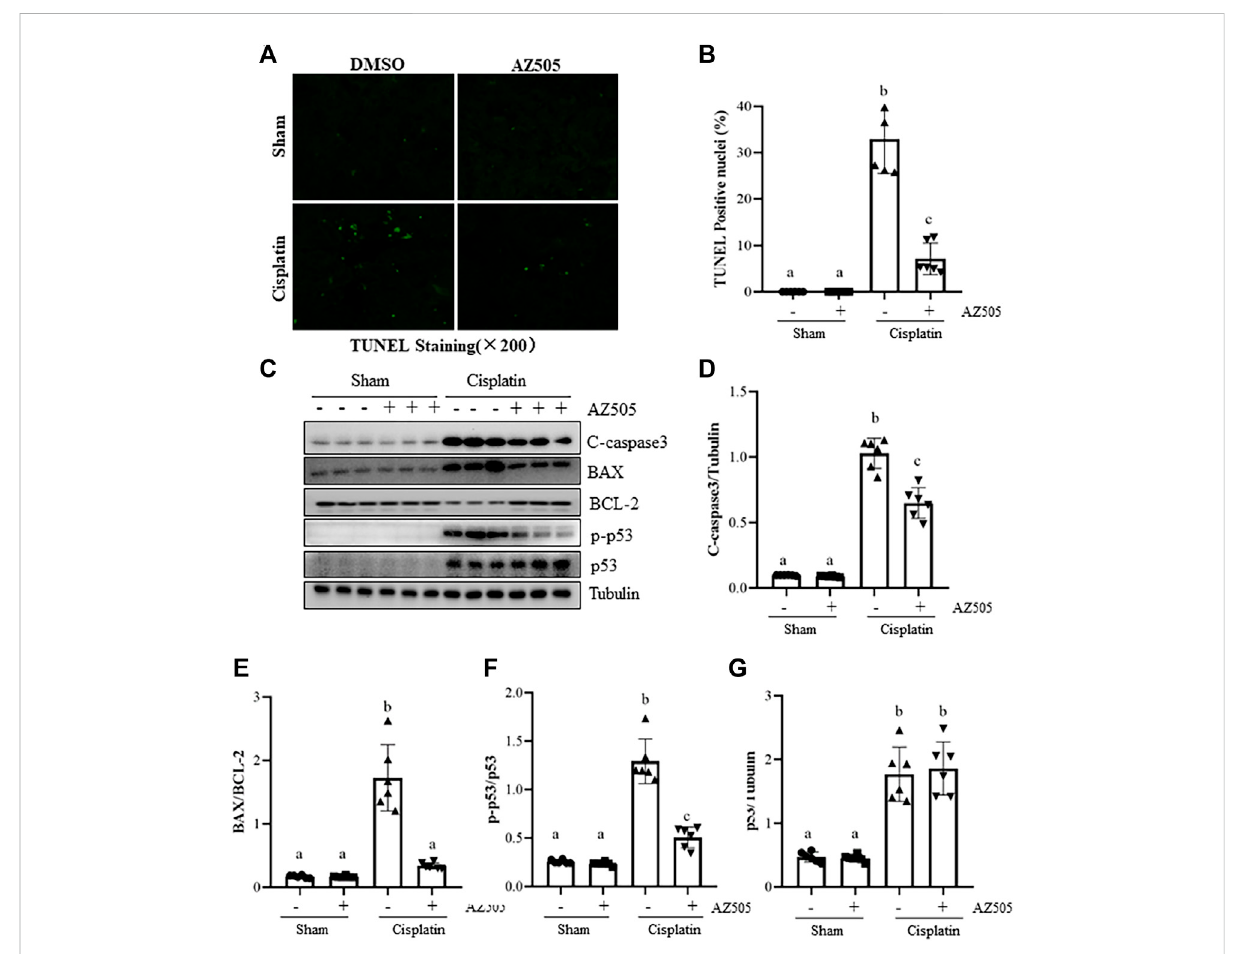
Administration of AZ505 reduces kidney tubular cells apoptosis induced by cisplatin. Photomicrographs illustrate TUNEL staining of the kidney tissuescollectedat48 haftercisplatininjectionwithorwithoutAZ505administration. (B) Thenumberofpositive TUNELstainingcellswerecounted in10high-power fi elds(×200). (C) Thekidneytissuesweretakenforimmunoblotanalysisofcleaved-Caspase-3,BAX,BCL-2,phospho-p53(p-p53), total p53 and Tubulin as indicated. Representative immunoblots from 3 experiments are shown. (D – G) Expression levels of cleaved-Caspase- 3 (D) ,BAX/BCL-2ratio (E) andp53 (G) werequanti fi edbydensitometryandnormalizedwith β -Actin,alongwithp-p53 (F) normalizedwithtotalp53as indicated. Data are means ± S.E.M. ( n = 6). Means with different superscript letters are signi fi cantly different from one another ( p <